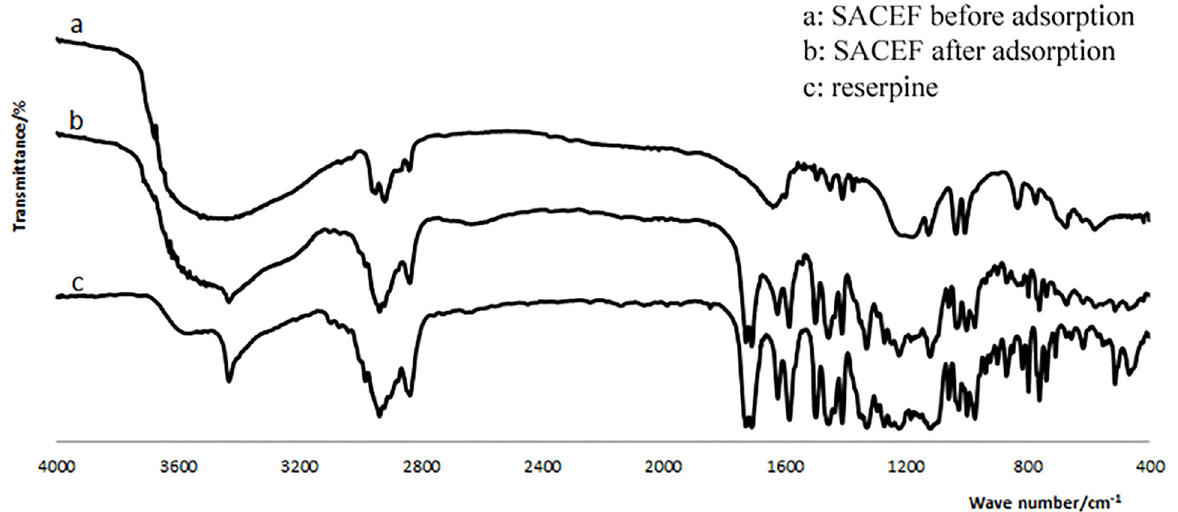
Fig 10. FTIR spectra of the SACEF before and after adsorption of